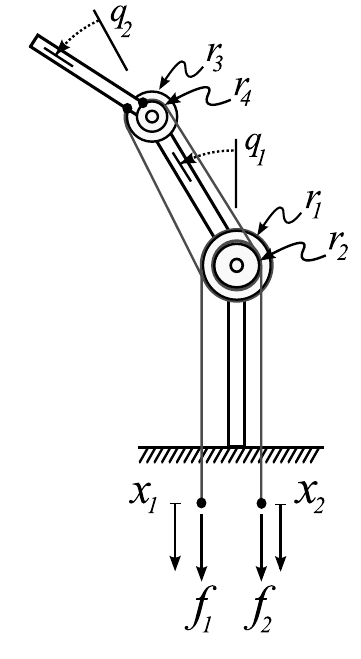
Figure 2. A 2 DOF finger with two tendons. x 1 represents the flexor tendon and x 2 the